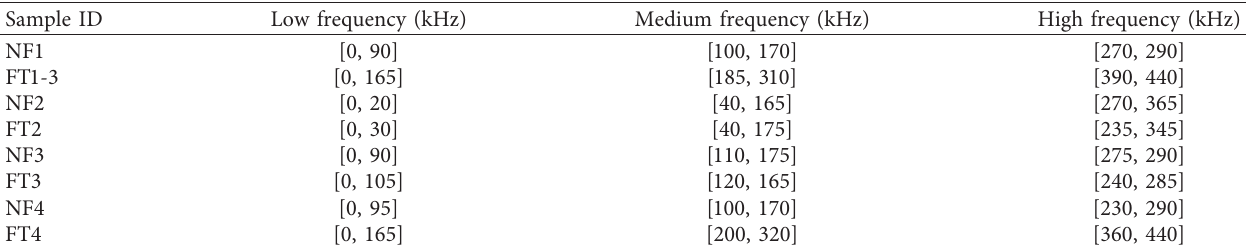
Table 2: Frequency band width of AE of tuff samples under different stress